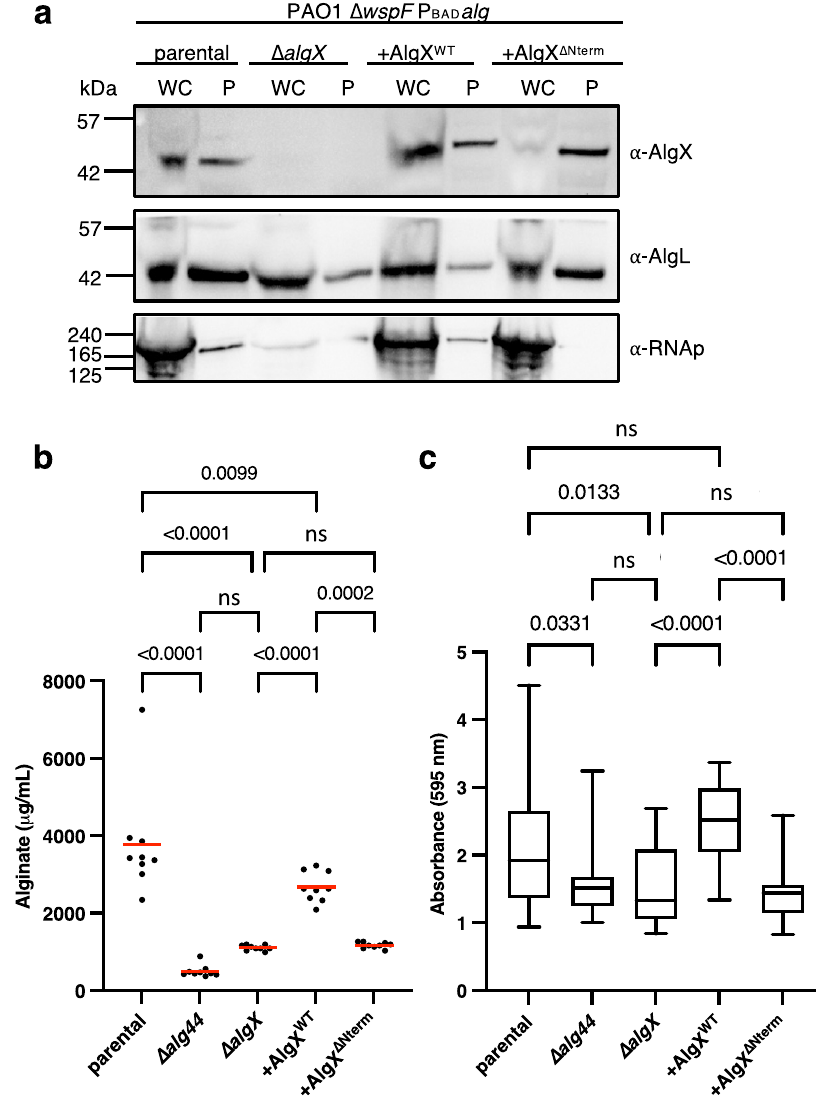
Fig. 5 | Formation of the AlgKX complex contributes to alginate production andbio fi lmadherencein P.aeruginosa .a Westernblotanalysisofthenormalized whole cell sample (WC) used for the periplasmic extraction and normalized peri- plasmicfractions(P)ofPAO1 Δ wspF P BAD alg (parental),PAO1 Δ wspF P BAD alg Δ algX ( Δ algX ), PAO1 Δ wspF P BAD alg Δ algX attTn7 ::P BAD algX (+AlgX WT ), and PAO1 Δ wspF P BAD alg Δ algX attTn7 ::P BAD AlgX Δ Nterm (+AlgX Δ Nterm ) strains expressing AlgX, AlgL (periplasmic control and loading control for P), and RNA polymerase (RNAp — cytoplasmic control). Detection of AlgX, AlgL, and RNAp was performed on the same blot. This experiment was repeated independently two other times. b Quanti fi cation of alginate produced over the course of 24h by the indicated